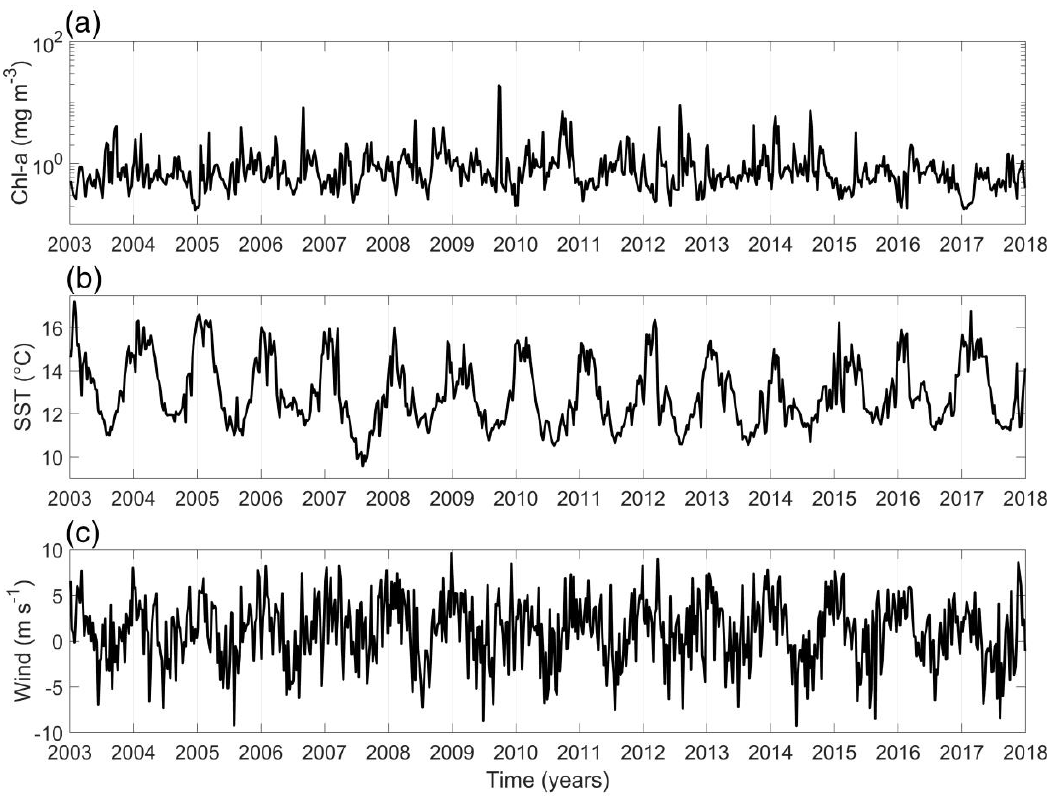
Figure 4. Time series of maximum Chl-a (8-day composite) ( a ) and minimum SST (daily composite) ( b ) north of the Punta Galera (~39.25 ◦ S, Figure 3, rectangle white 1) and ( c ) mean alongshore SSW (daily) closest to Punta Galera (~40 ◦ S, Figure 3, rectangle white 2).